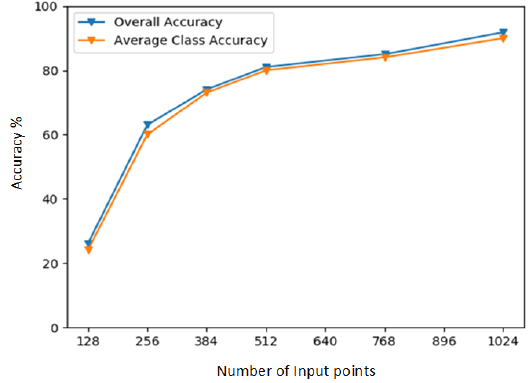
Figure 6. The graph of Figure 5 is depicted in Figure 6. The Curve in a graph represents the testing result of DFT-Net. The final model is trained with 1024 number of points having k = 20.